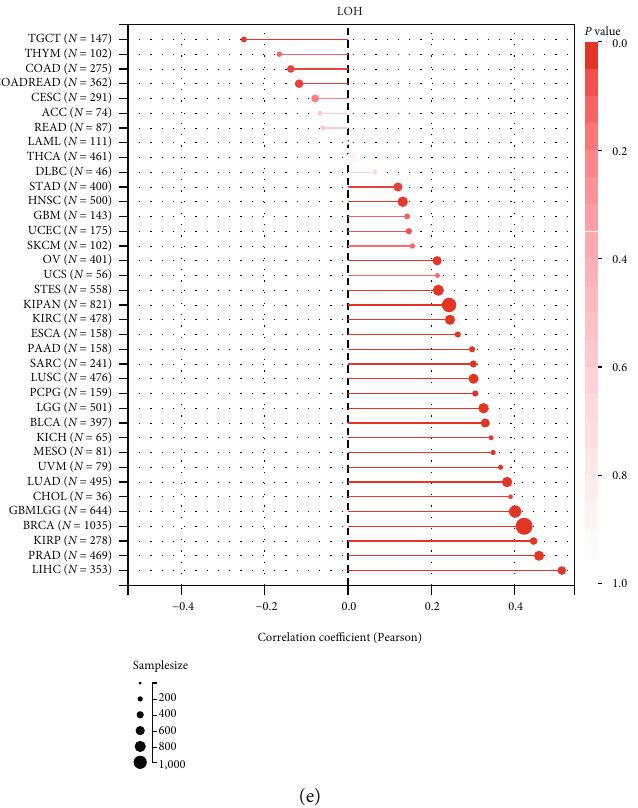
Figure 6: The relationship between PRC1 and genome instability of LIHC. (a) Landscape of somatic mutation in high and low PRC1 expression LIHC subpopulations. Genes are ranked by mutational frequency. Upper panel displays TMB score of each patient. (b – e) The relationship of PRC1 expression with TMB (b), MSI (c), HRD (d), and LOH